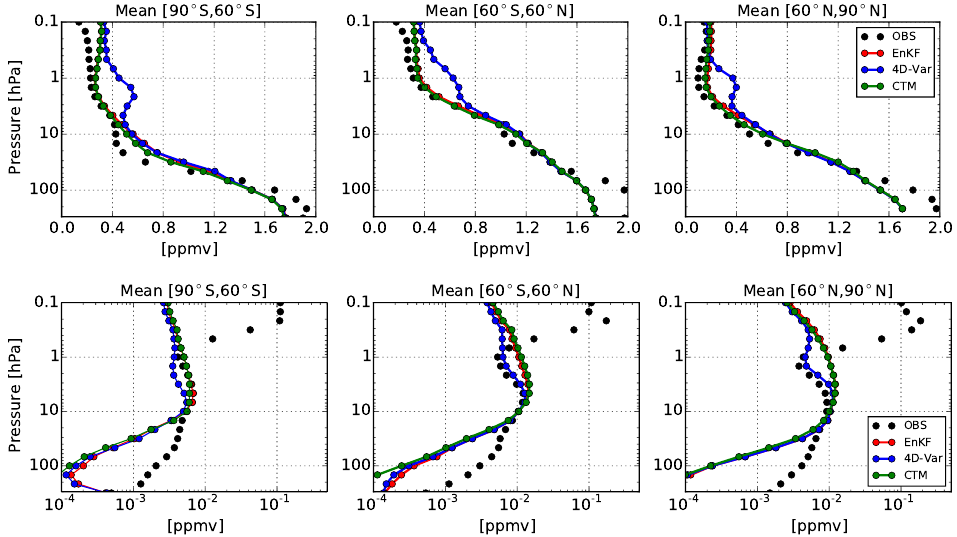
Figure 9. Verification of non-observed species from CTM (green), 24h forecasts from EnKF (red) and 4D-Var (blue) assimilation against MIPAS IMK data (black dots): mean CH 4 (top) and mean NO x (bottom) profiles. The statistics are computed for September–October 2008 and for three latitude bands (from left to right: South Pole, tropics–middle latitudes and North Pole).